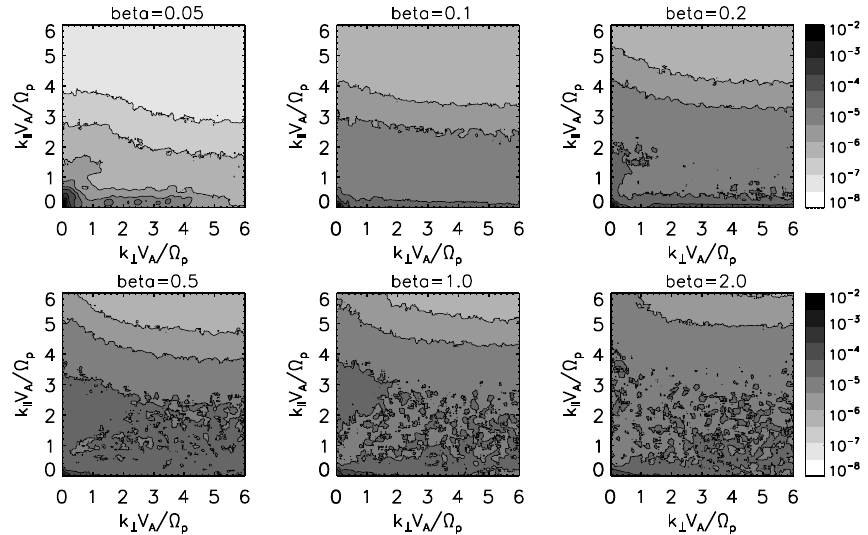
Figure 2. Magnetic energy spectra obtained by numerical simulation of two-dimensional ion-scale plasma turbulence at a late-stage time evolution (2000 ion gyroperiods). The panel styles are the same as those in Fig. 1